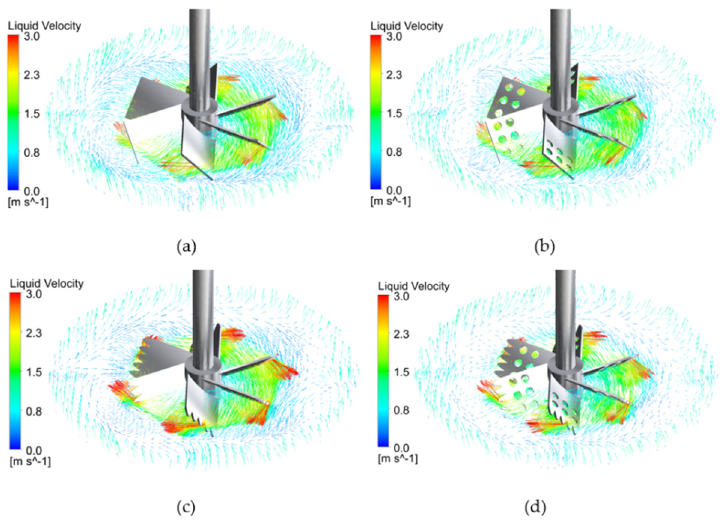
Figure 8. Liquid velocity vectors profile around the different impeller blades. ( a ) PBT, ( b ) PBPT, ( c ) BCBT, ( d ) BCPBT.